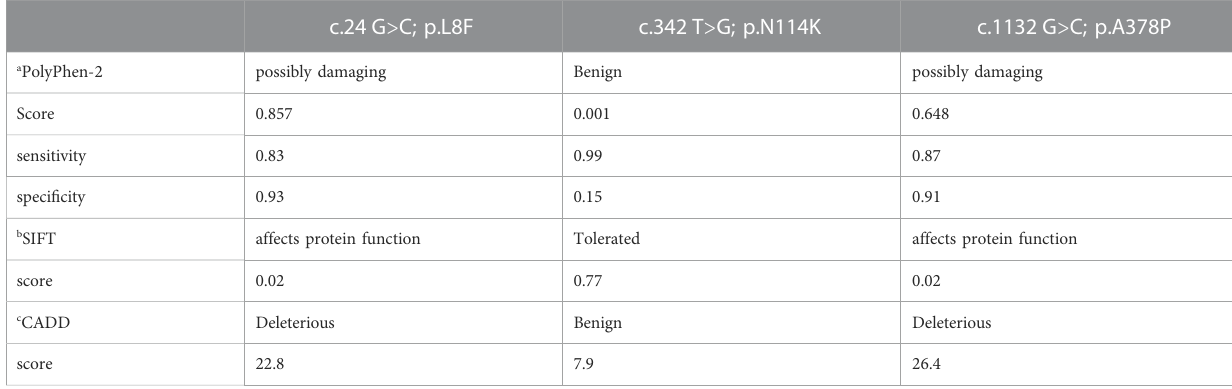
TABLE 2 In-silico variant impact prediction